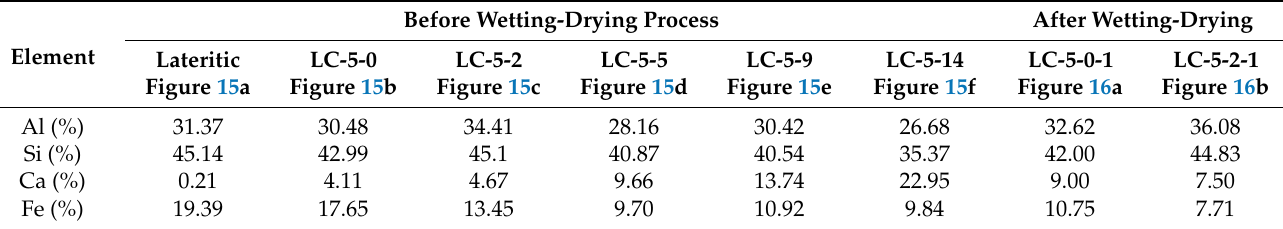
Figure 15. SEM photos of samples of lateritic-cement-additive before wetting-drying cycles ( a ) Lateritic soil, ( b ) LC-5-0-1, ( c ) LC-5-2-1, ( d ) LC-5-5-1, ( e ) LC-5-9-1, and ( f ) LC-5-14-1. Table 8. Chemical elements of lateritic–cement–additive